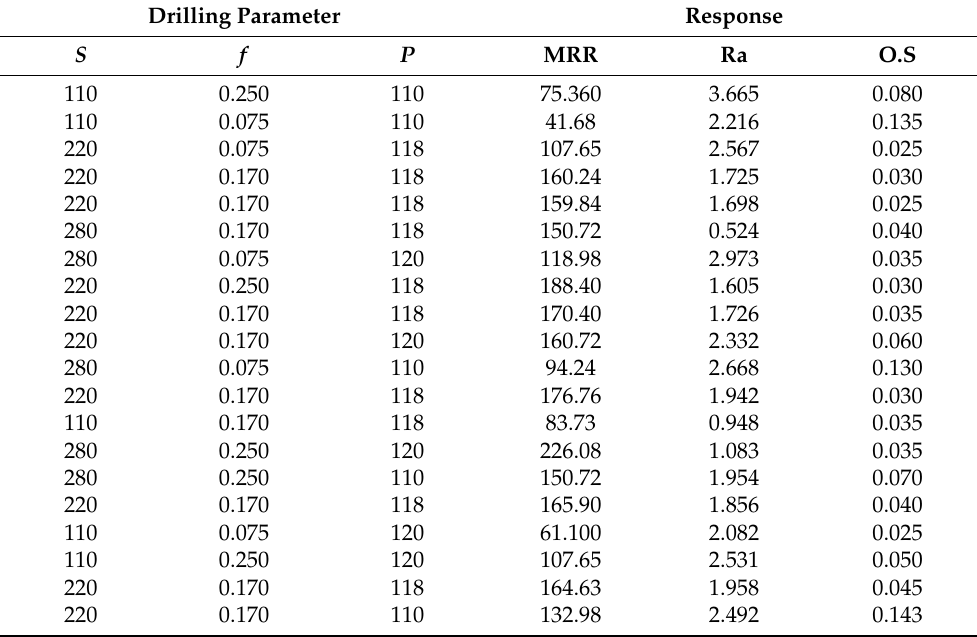
Table 8. Drilling parameters and responses